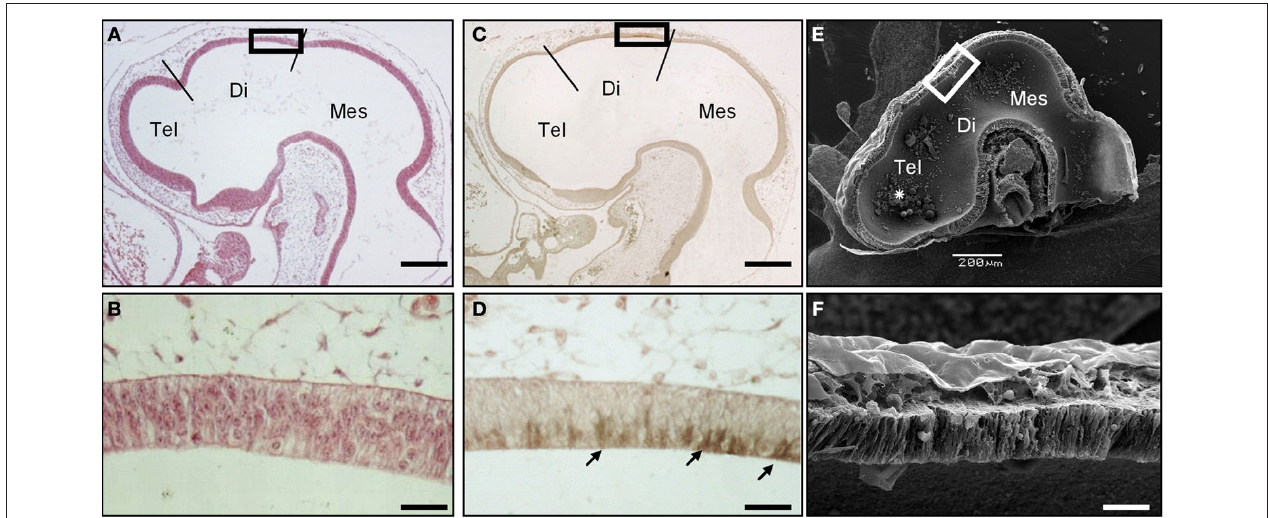
(asterisk in E ). (B,D,F) Higher magnification of the diencephalic roof plate region boxed in (A,C,E) , respectively. At this early developmental stage, while the diencephalic roof plate does not present any marked morphological difference from the rest of the neuroepithelium, it strongly expresses SCO-spondin. Tel, Telencephalon; Di, Diencephalon; Mes, Mesencephalon; Scale bars represent 200 μ m in (A,C,E) ; 25 μ m in (B,D,F)